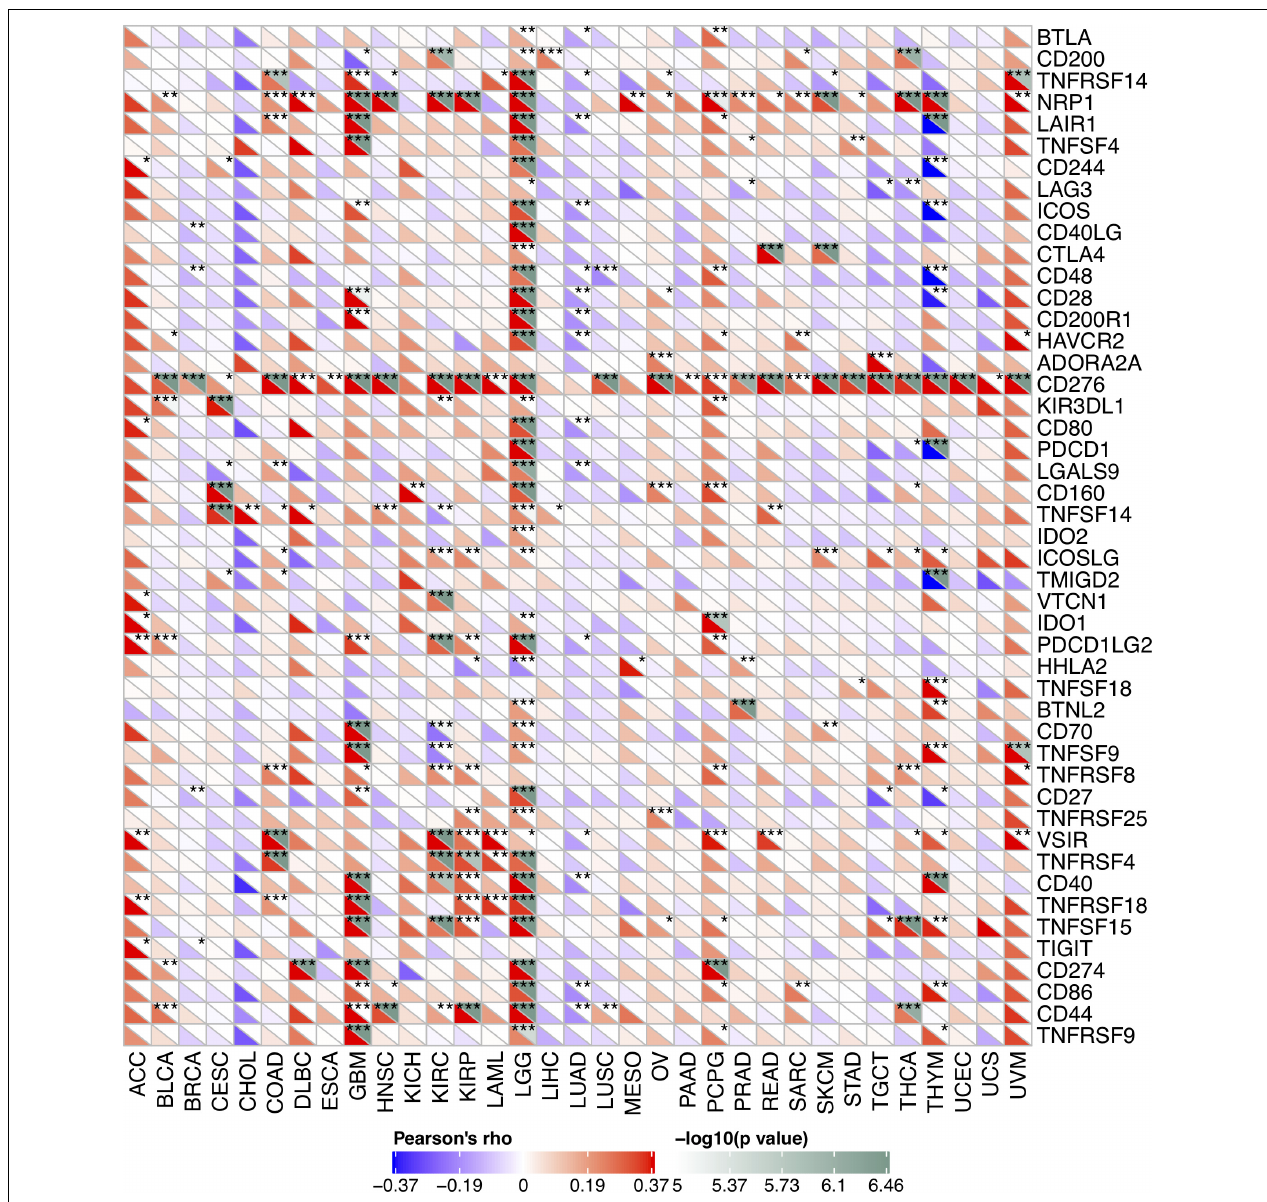
FIGURE 7 | Correlation of FURIN expression with 47 common immune checkpoint gene expression across cancers. * p < 0.05, ** p < 0.01, *** p <